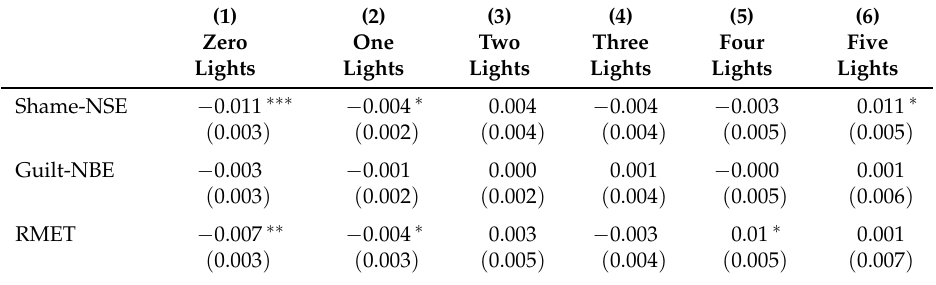
Table 5. Predicting number of lights by shame, guilt, and ToM: Marginal